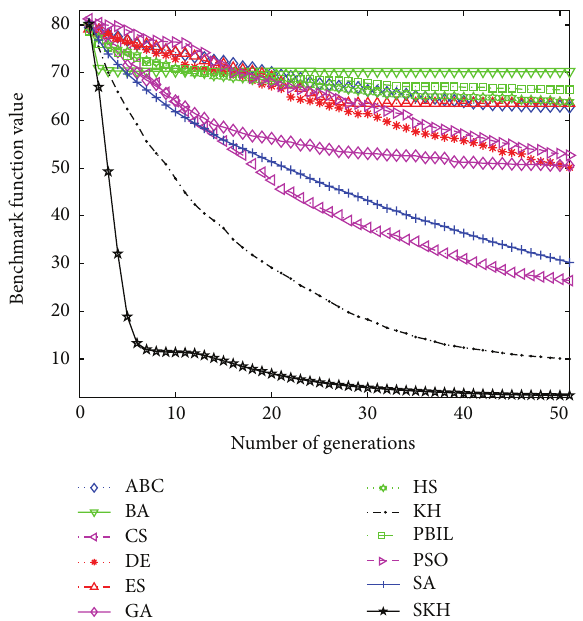
Figure 6: Comparison of the performance of the different methods for the F12 Schwefel.